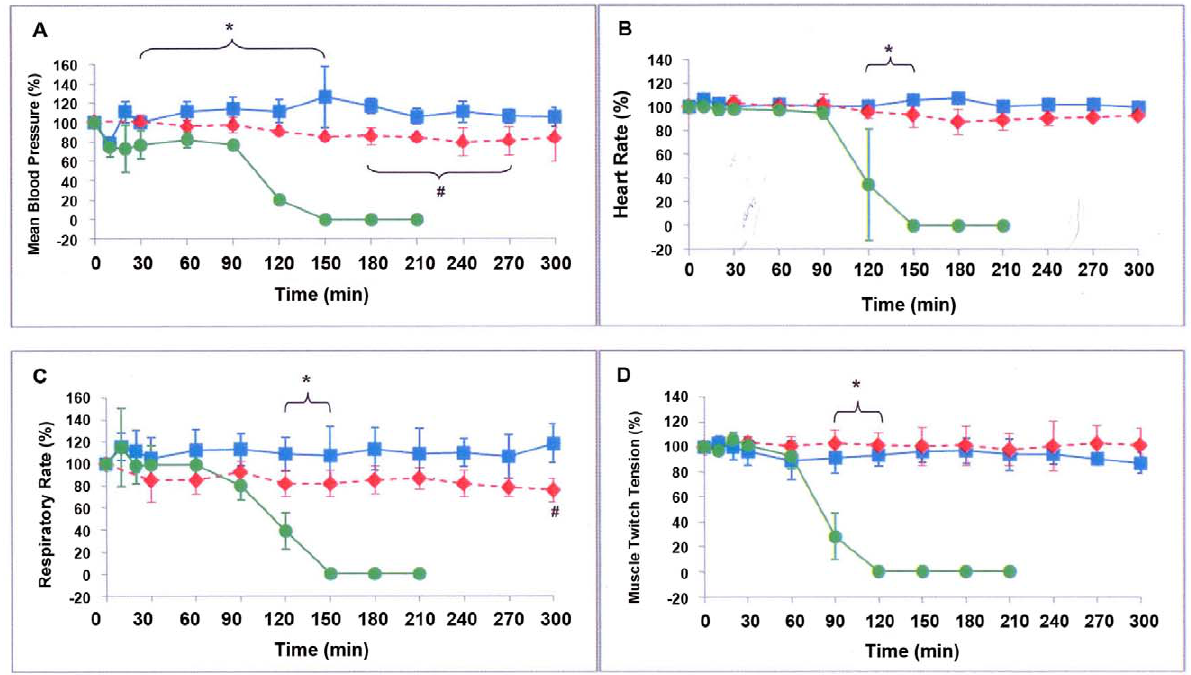
Figure 3. Effects of Neuro Polyvalent Snake Antivenom (NPAV) on the cardio-respiratory depressant and neuromuscular blocking effects. Changes in percentage (%) of (A) mean blood pressure, (B) heart rate, (C) respiratory rate and (D) muscle twitch tension, upon intramuscular injection of N. sputatrix venom (6 mg/kg) at 0 min in ‘NsV/-’ group (n=3; green circle) and ‘NsV/NPAV’ group (n=3; blue square ); and intramuscular injection of saline in ‘saline/-’ group (n=3; red diamond) , which served as the control group. The ‘NsV/NPAV’ group received intravenous injection of 1 mL NPAV each at 10, 30 and 50 min (3 mL in total) post venom injection. *P , 0.05 by one-way ANOVA between the ‘NsV/-’ group and ‘NsV/NPAV’ group, within the range indicated by the curly bracket. # P , 0.05 by one-way ANOVA between the ‘saline/-’ group and ‘NsV/NPAV’ group, within the range indicated by the curly bracket. The animals in ‘NsV/-’ group died within 125–130 min upon venom injection. All values are expressed as mean 6